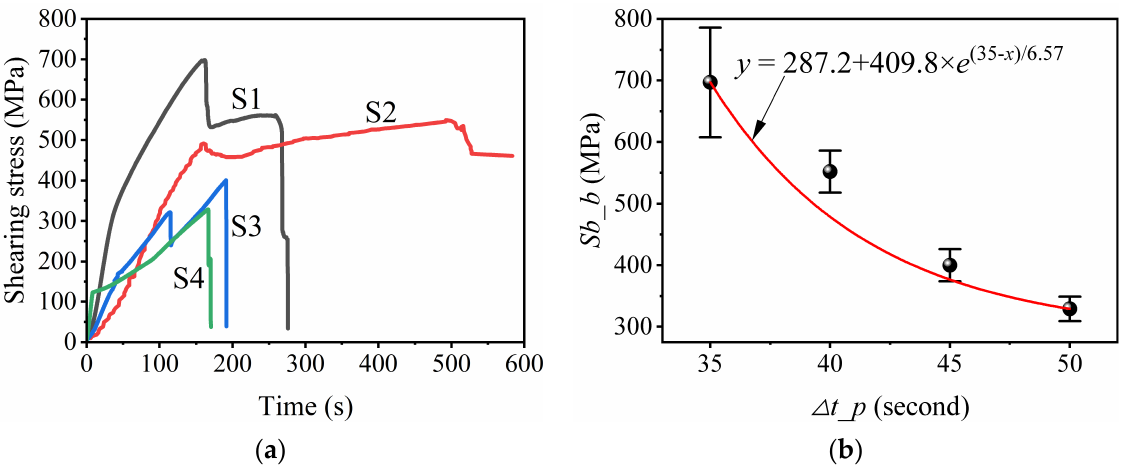
Figure 11. Shearing stress vs. test time curves ( a ) and pouring time interval dependence on interfacial bonding strength ( b ) of different specimens.